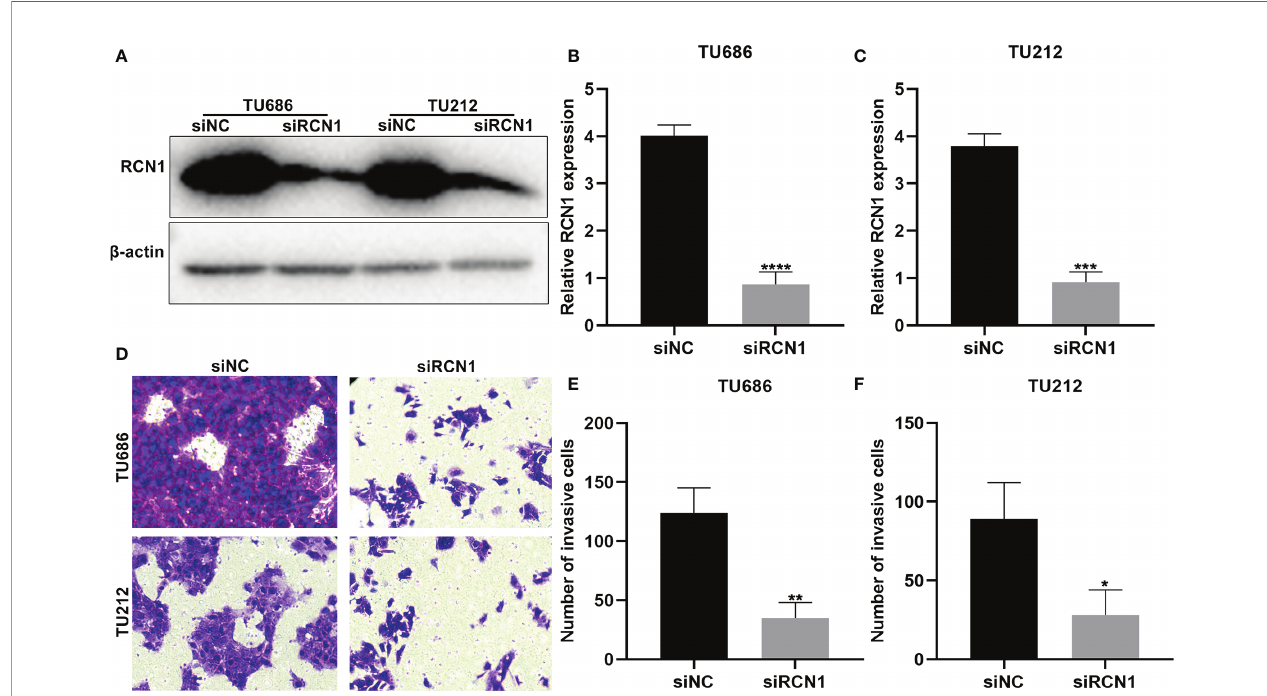
FIGURE 8 | RCNA1 knockdown lowers invasion of laryngeal cancer cells. (A – C) Western blot for detection of RCNA1 expression in TU686 and TU212 cells transfected with siRCNA1. (D – F) Transwell for detection of the invasion of TU686 and TU212 cells transfected with siRCNA1. *P < 0.05; **p < 0.01; ***p < 0.001; ****p <